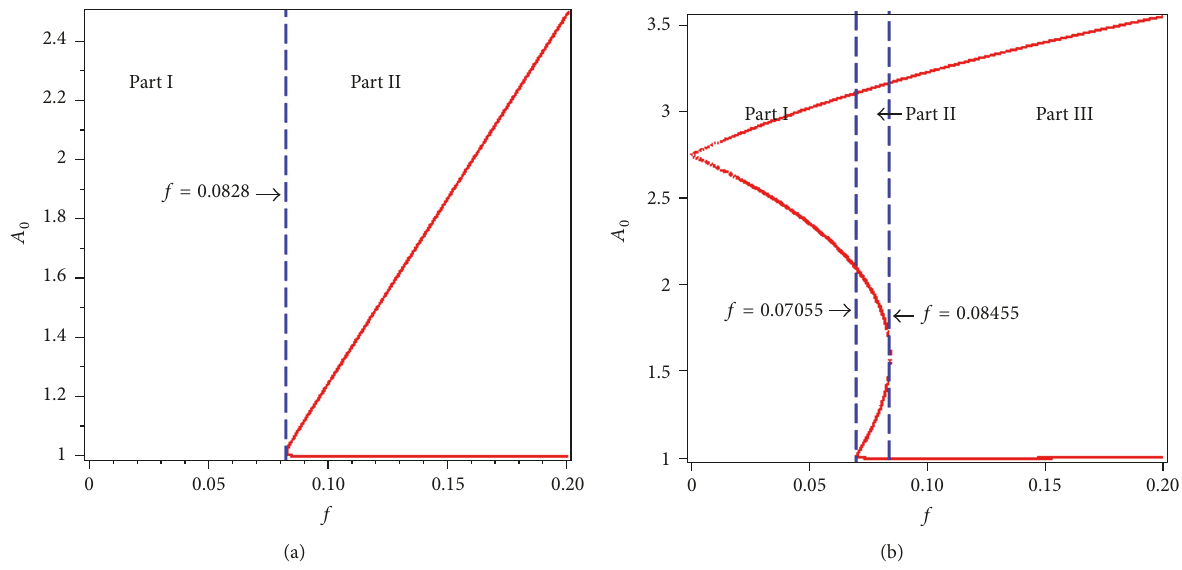
Figure 4: Verification of the response properties shown in Figure 3. (a) 𝜏 = 𝜋/2 ; (b) 𝜏 = 3𝜋/4